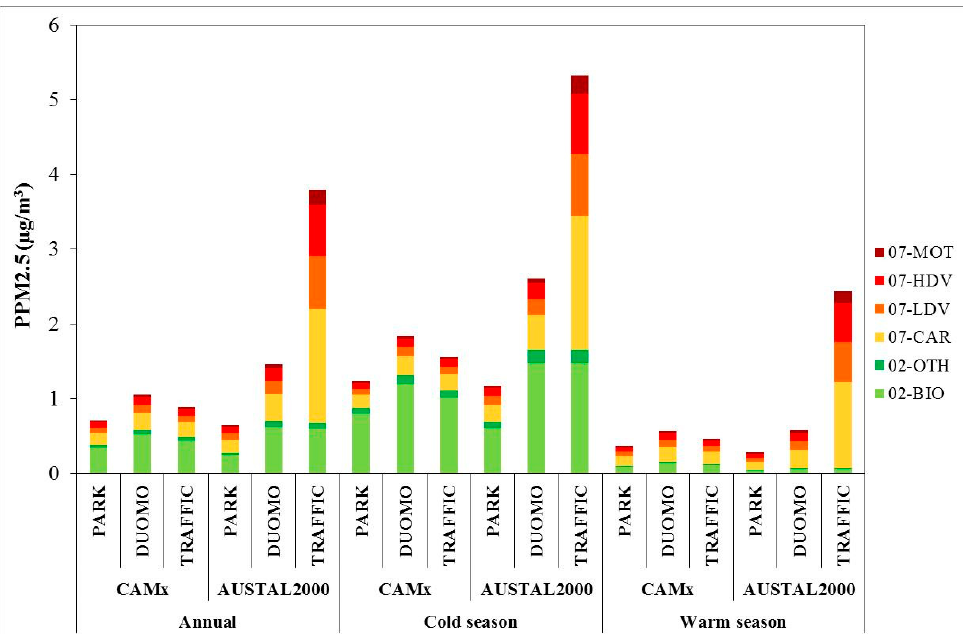
Figure 5. Primary PM2.5 levels and source apportionment comparison between CAMx and AUSTAL2000 at the urban receptors (PARK, DUOMO, TRAFFIC) for LOCAL region emissions.